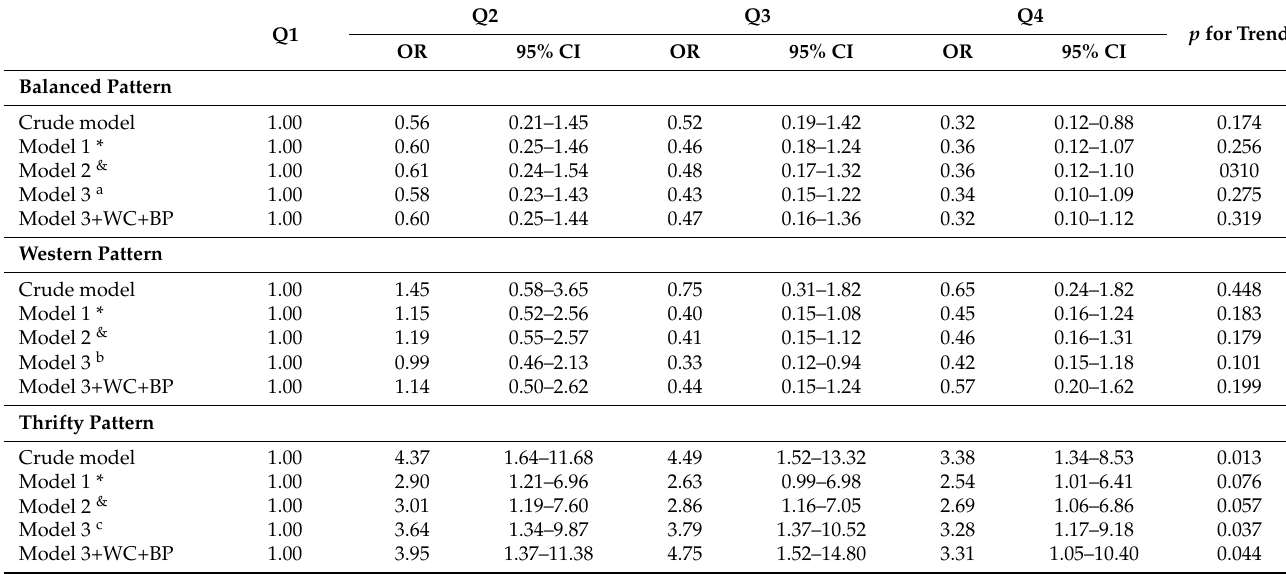
Table 5. Association between low HDL-C and quartiles of dietary patterns in the older participants by BMI subgroups (BMI < 21.6 kg/m 2 ).